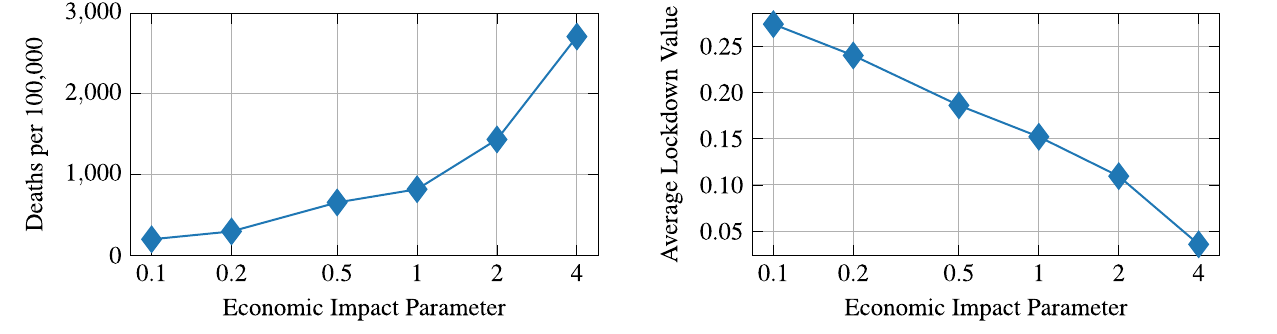
Figure 8. Comparisons of the results of using different values for the economic impact parameter when solving for optimal lockdown policies.